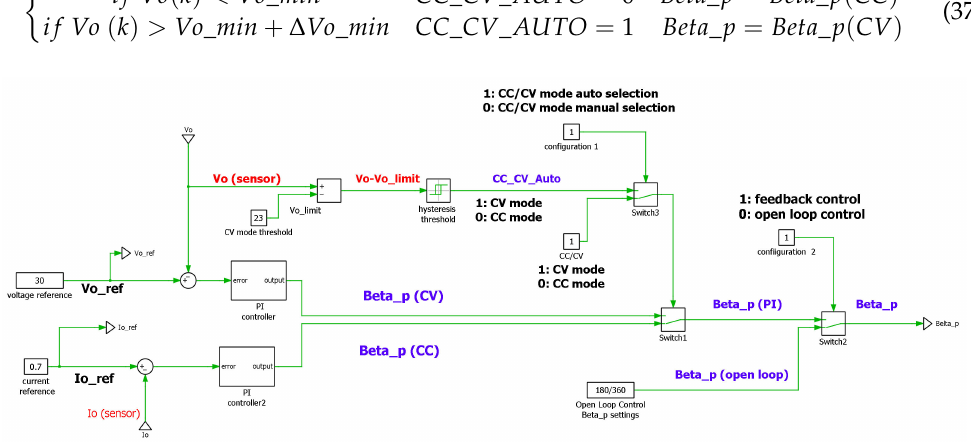
Figure 11. Inverter phase shift angle β p generation in PLECS RT Box for experimental testing